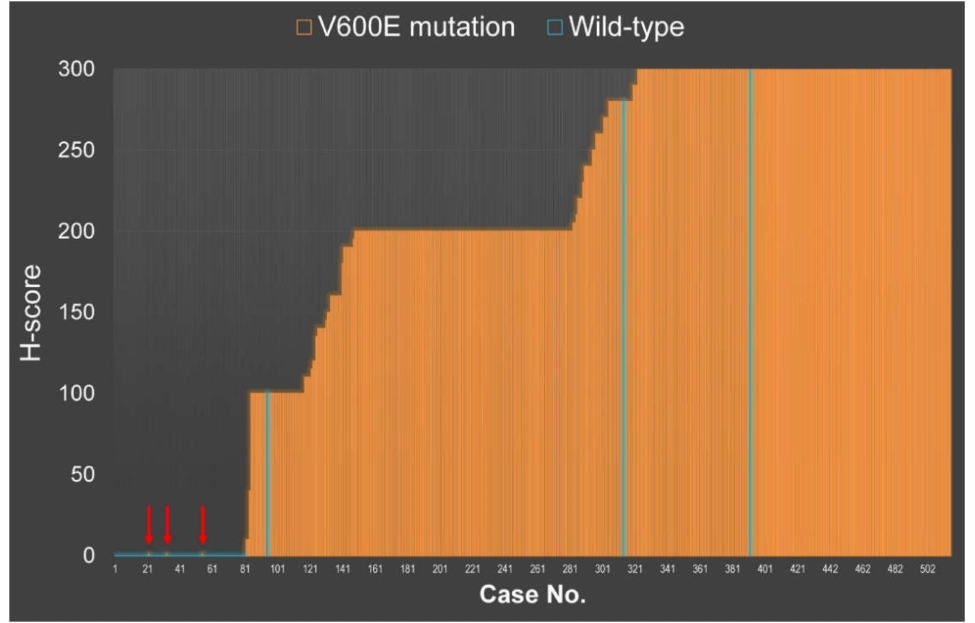
Figure 3. H-score for VE1 staining plotted against BRAF exon 15 genotype using Sanger sequencing. Arrows indicate 3 cases with initially VE1 false negative results. Three cases with initially VE1 false positive results (light blue lines on orange background) showed BRAF V600E mutation using digital